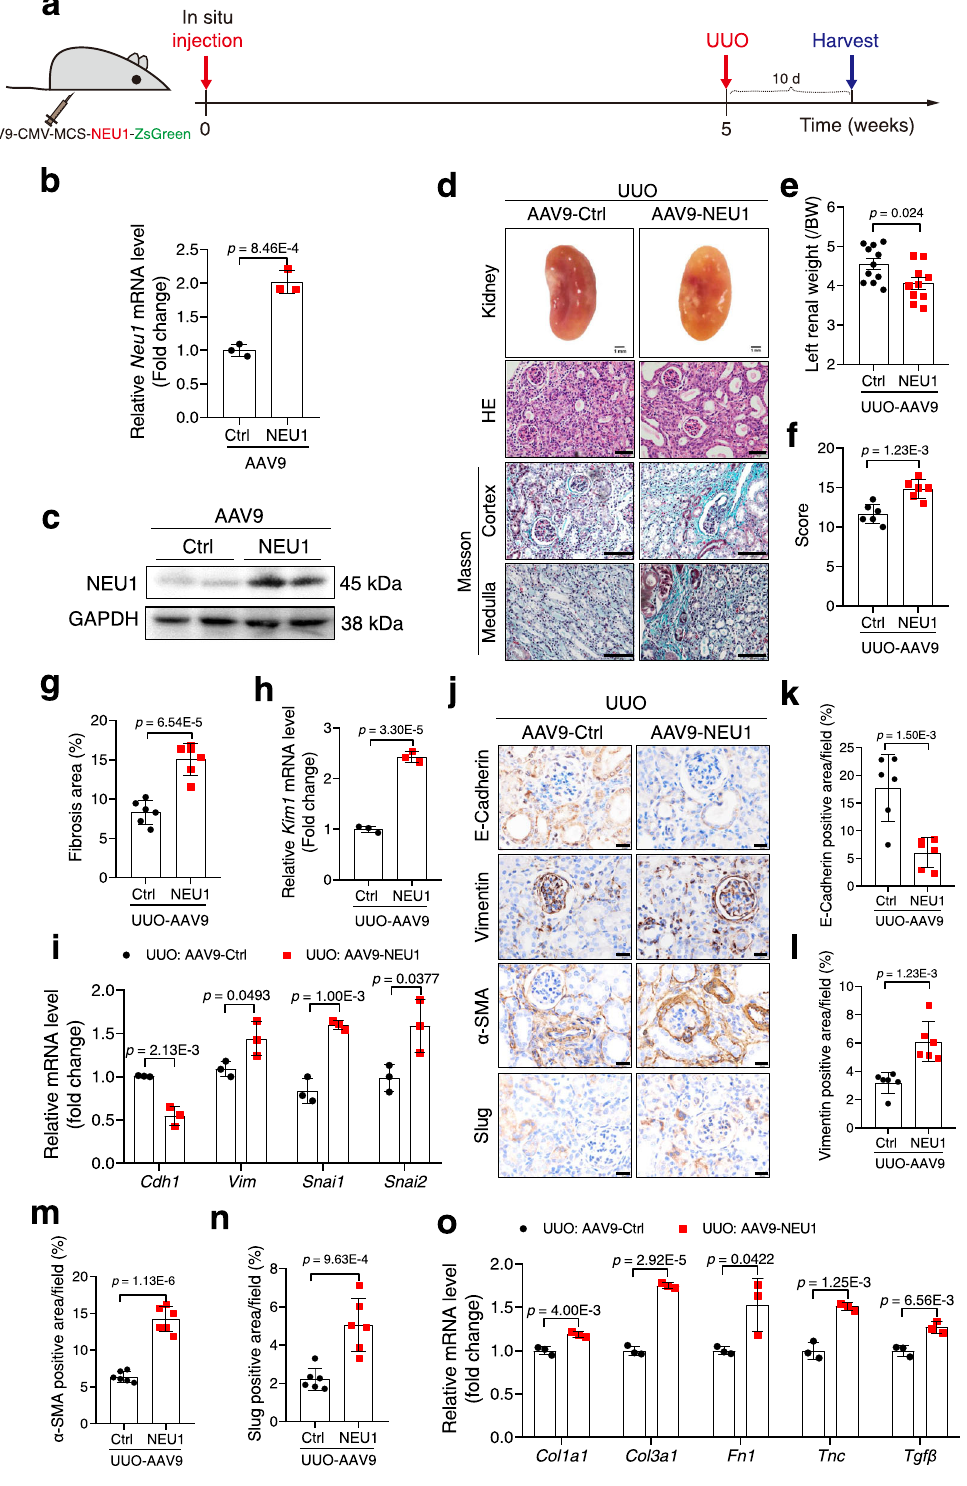
Fig. 5 | NEU1 overexpression aggravates UUO-induced renal fi brosis. a Schematic diagram of NEU1 overexpression in mice. Mice were in situ injected with AAV9 encoding NEU1 or scramble. After the injection for 5 weeks, the mice were subjected to UUO surgery. b mRNA levels of Neu1 in the cortices of kidneys. n =3 mice per group. c NEU1 protein levels in the kidneys of AAV9-Ctrl and AAV9- NEU1 mice. n =2 mice per group. d The gross appearance of kidneys (Scale bar, 1mm), kidney cross-sections stained with HE (Scale bar, 50 μ m), and Masson ’ s trichrome(Scalebar,100 μ m). n =6micepergroup. e Theratioofleftrenalweight to body weight (BW, mg/g). AAV9-Ctrl, n =11; AAV9-NEU1, n =10. f Statistical